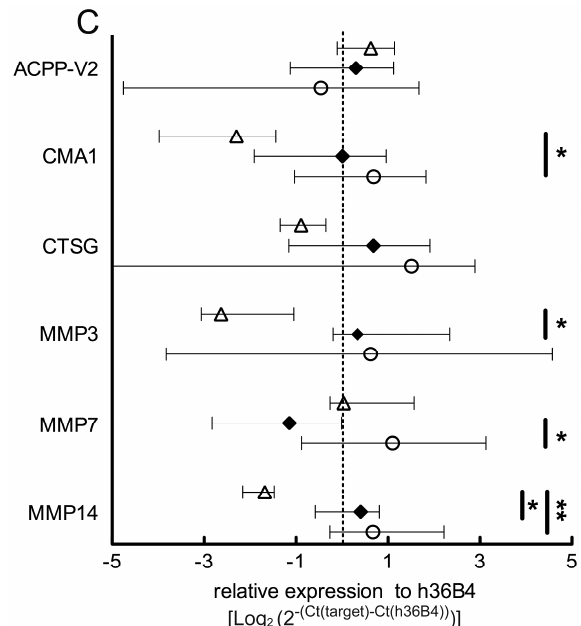
Figure 1. Gene expression analysis. ( A – C ) Expression levels compared to h36B4, global normalization; ( A ) High abundance genes (ratio > 1.0); KLK3 (PSA): kallikrein related peptidase 3; ACPP: total prostatic acid phosphatase; ACPP-V1: splice variant 1 (short secreted isoform of ACPP). The observed differences in mRNA levels between PCa ( n = 12), benign prostatic hyperplasia (BPH) ( n = 10) and normal Prostate (nP; n = 7) were not significant. However, range of KLK3 expression was much higher in BPH and PCa; ( B ) TIMP1 and TIMP2 expression was significantly different between BPH and nP samples; ( C ) Low abundance genes (ratio < 1.0); ACPP-V2: splice variant 2 (long intracellular isoform); CMA1: chymase 1, CTSG: cathepsin G, and MMP: matrix metalloproteinase. Differential expression levels were detected for CMA1, MMP3, MMP7 and MMP14. Symbols represent medians, whiskers indicate interquartile range. Global normalization; interquartile range: 25%–median–75%; significance: Kruskal–Wallis test and Dunn’s multiple comparison test; * p < 0.05, ** p < 0.01).